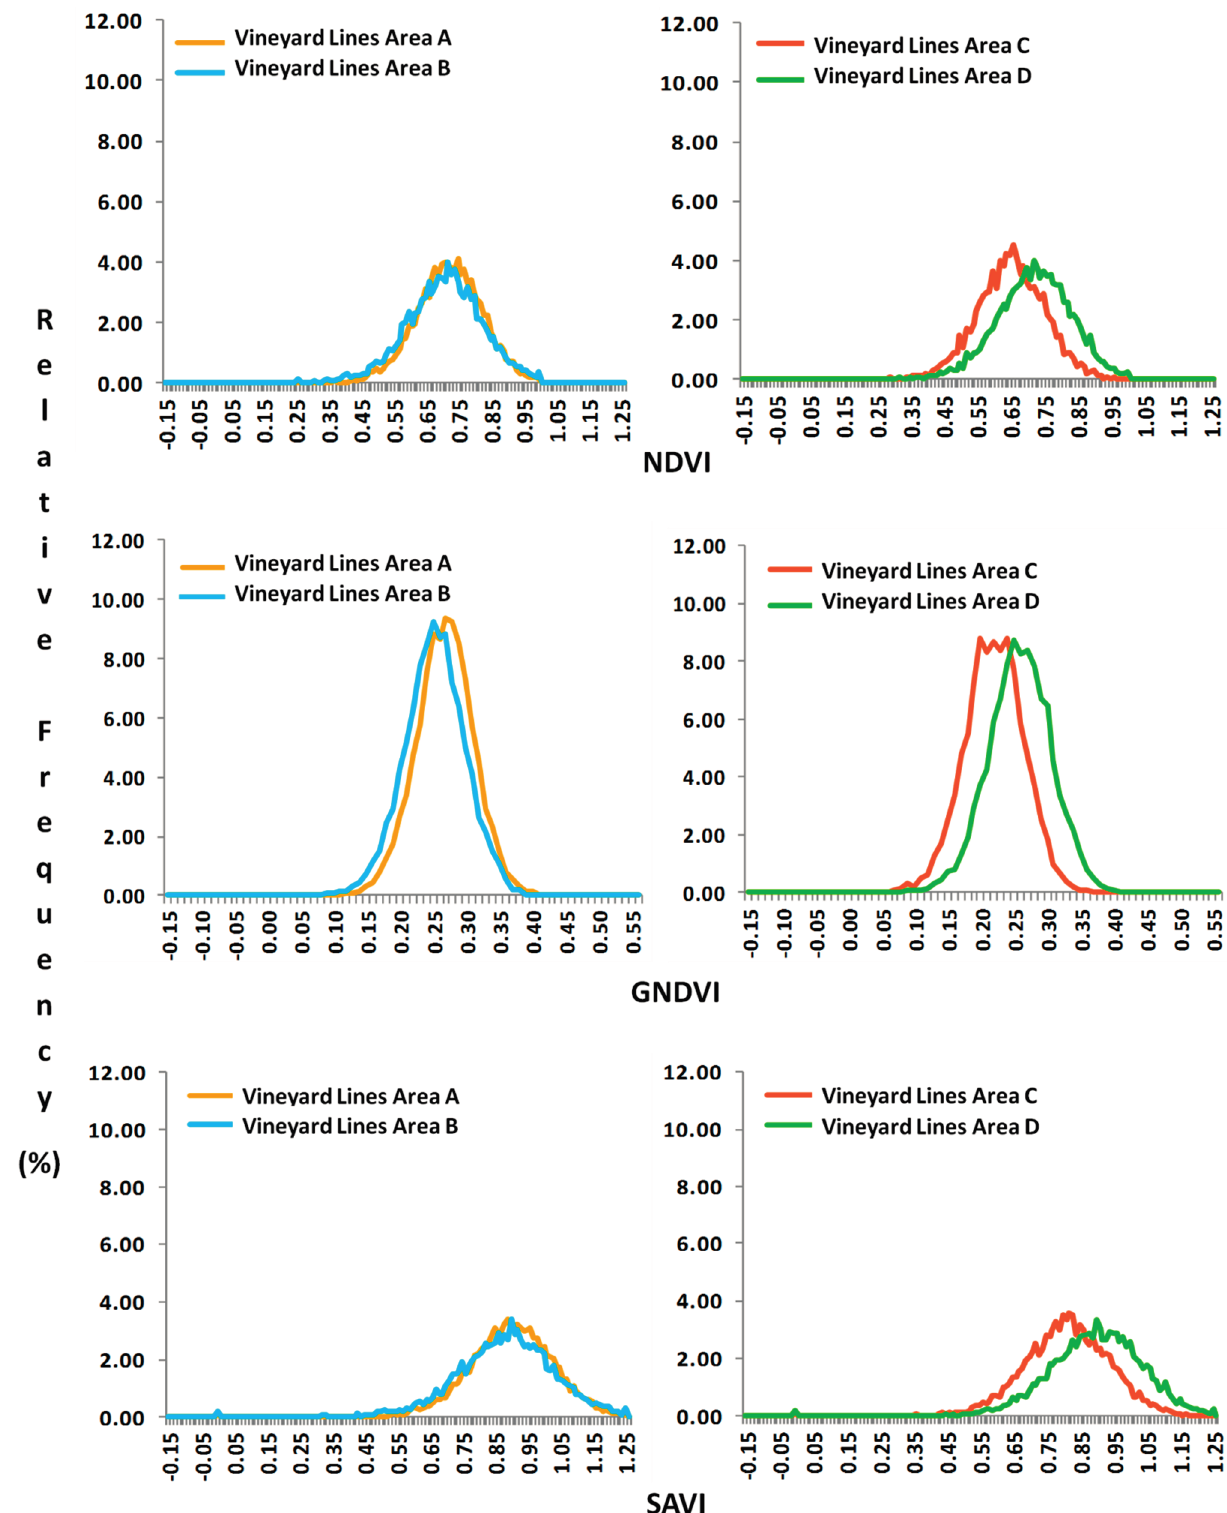
Figure 11. Relative frequency histograms of NDVI, GNDVI, SAVI, and values for areas A, B, C, and D. Given the different nature of the GNDVI index, a different range was used for the horizontal axis of the